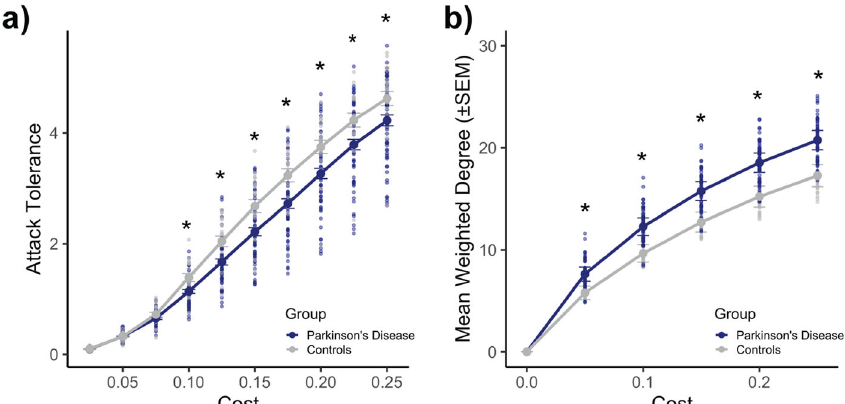
Fig. 4 Parkinson ’ s disease vs. control group comparisons of attack tolerance and weighted degree of the frontoparietal network. All analyses were performed on thresholded matrices. a Targeted-attack analysis. The PD group displayed signi fi cantly reduced attack tolerance relative to the healthy control group across seven of the 10 costs examined (random-permutation test, p -values > 0.08 for costs 2.5 – 7.5%; otherwise, p -values < 0.03). b Mean (±SEM) weighted degree of nodes within the frontoparietal network. The control group displayed signi fi cantly reduced weighted degree across all of the valid costs examined (random-permutation test, all p -values < 0.0002). Comparisons reported here are between n = 59 individuals with PD and n = 21 controls. See Supplementary Tables 11 and 13 for complete summaries of